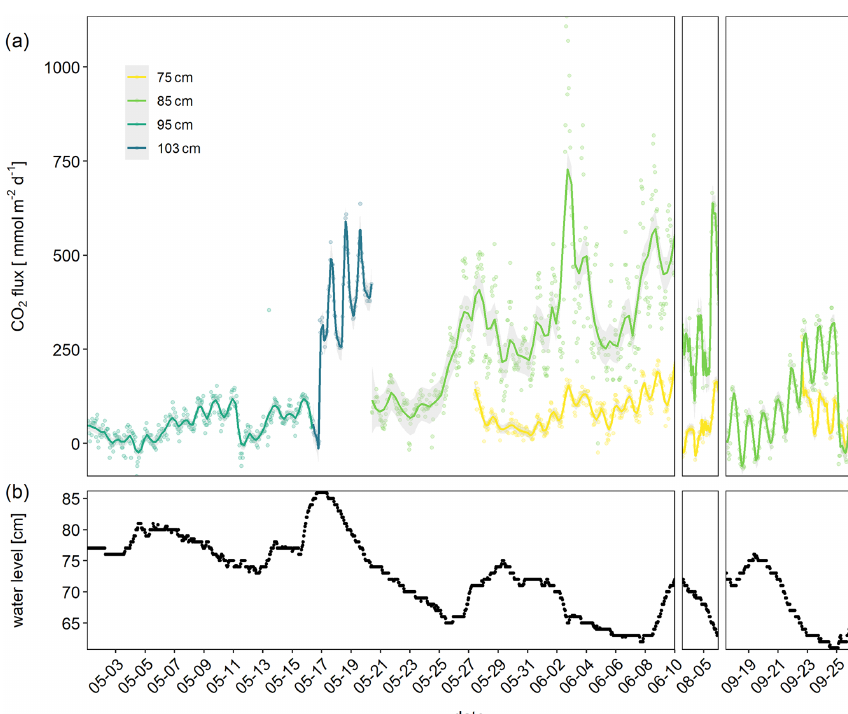
Figure 2. CO 2 fluxes in millimole per square meter per day measured with automatic chambers (a) and corresponding water level of the river measured 13km downstream at the gauge Magdeburg Strombrücke (b) . Colors indicate the elevation of the chambers. For example the 75cm position means that the chamber was directly above the water line when the gauge reading was 75. Lines indicate smoothed data ± SD using locally estimated scatterplot smoothing (LOESS) smoother with a span 0.1. The grey areas indicate confidence